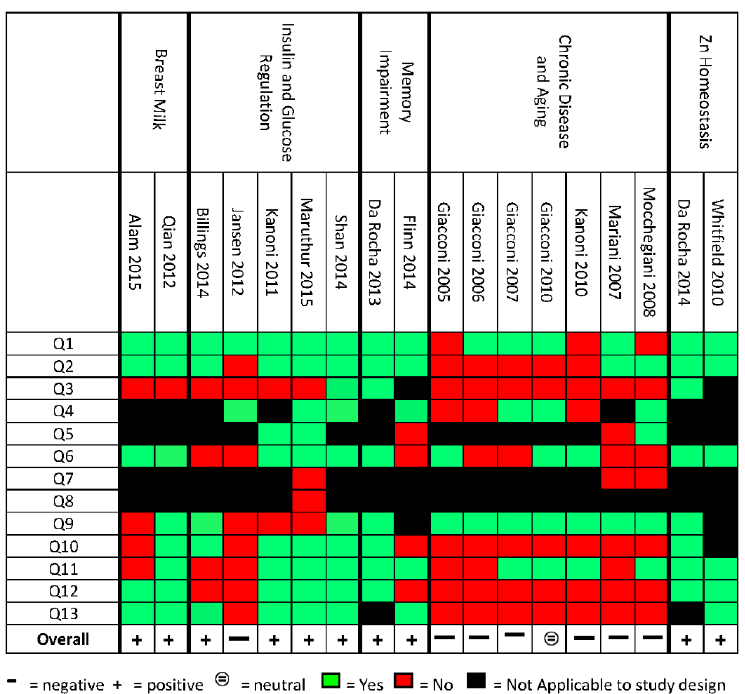
Figure 1. Quality Assessment (QA) results for each included study. Q1. Research question; Q2. Study Design; Q3. Subjects/patients bias; Q4. Group comparisons; Q5. Intervention/therapeutic description; Q6. Outcomes; Q7. Withdrawals; Q8. Blinding; Q9. Hardy-Weinberg equilibrium; Q10. Association between Zn intake or Zn status and Single Nucleotide Polymorphisms (SNPs); Q11. Appropriateness of statistics; Q12. Supported conclusions; Q13. Funding bias [29].